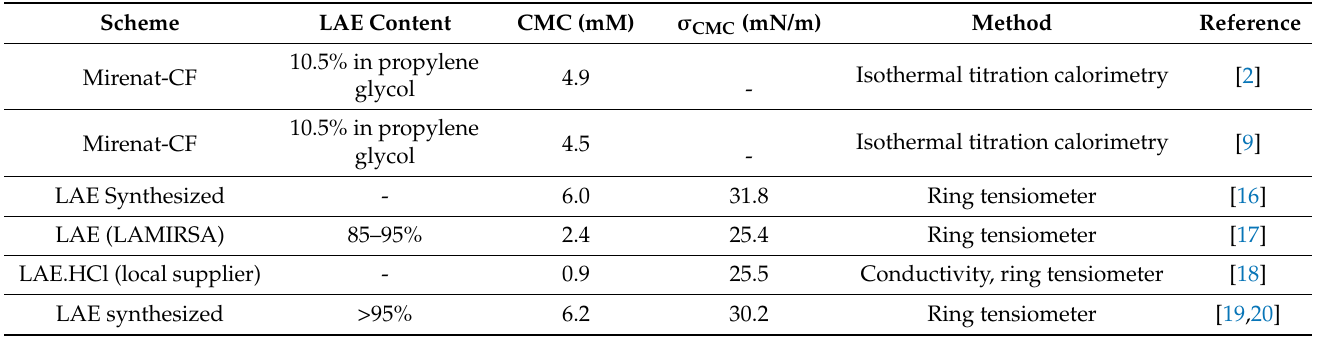
Table 1. The results of characterization of CMC of LAE solution by various